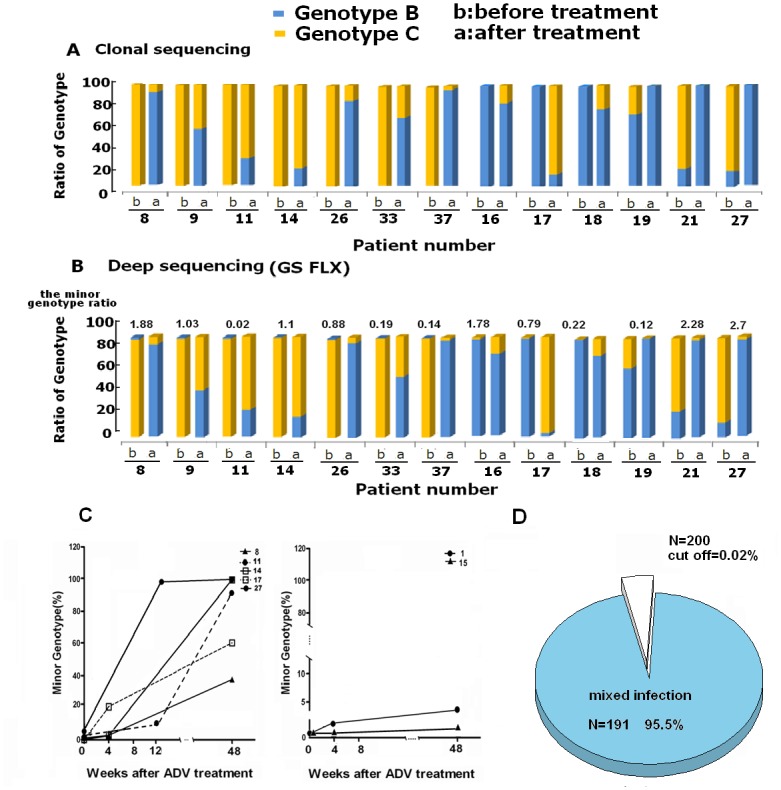
Prevalence of mixed genotype infection before ADV treatment in CHB patients.(A) Genotype distributions of 13 patients with genotype shift observed by clonal sequencing showed that 7 patients were genotype C, 3 patients were genotype B and 3 patients were mixed infection before drug treatment. (B) Genotype patterns observed by GS FLX revealed that all 13 patients were of mixed infection (B+C) before and after antiviral therapy. The ratios of minor genotype were on the top of figure, as determined by deep sequencing GS FLX. (C) The change of minor genotypes in course of ADV treatment. The genotype distributions in 13 patients were analyzed at week 0, week 4, week 12 and week 48 after ADV treatment. The alterations of minor genotype in 7 samples including 5 patients with genotype shift and 2 patients without genotype shift were presented. (D) The genotype distribution was analyzed in 200 CHB patients before ADV treatment by Solexa method. 95.5% patients showed mixed genotypes.